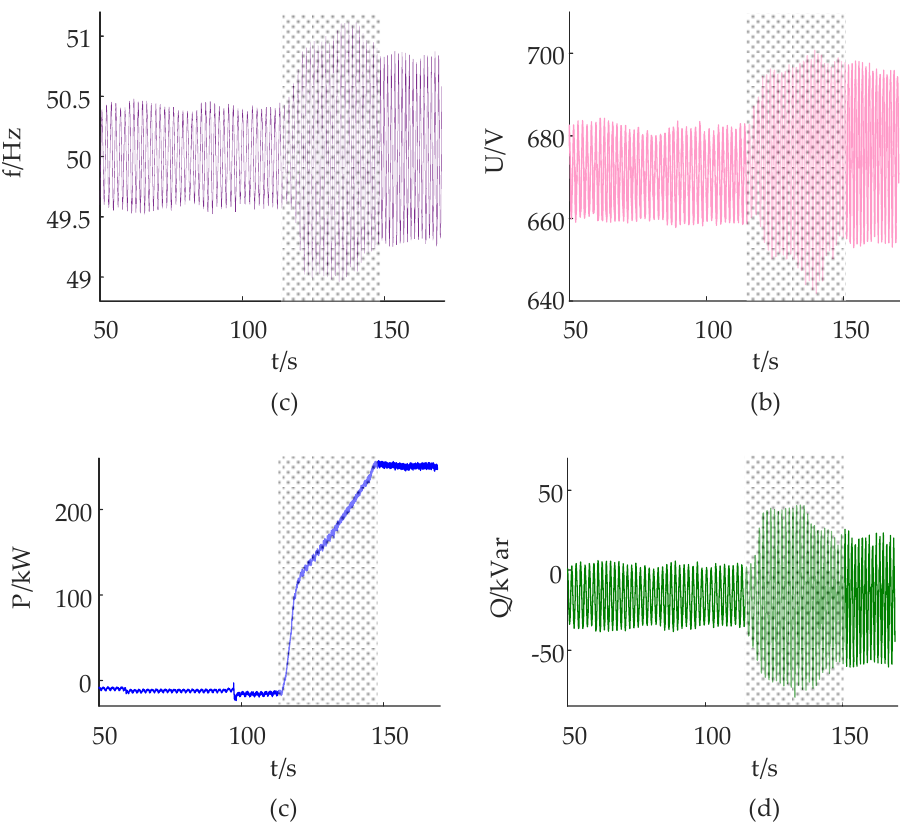
Figure 9. ( a ) system frequency, ( b ) system voltage, ( c ) active power, ( d ) reactive power.